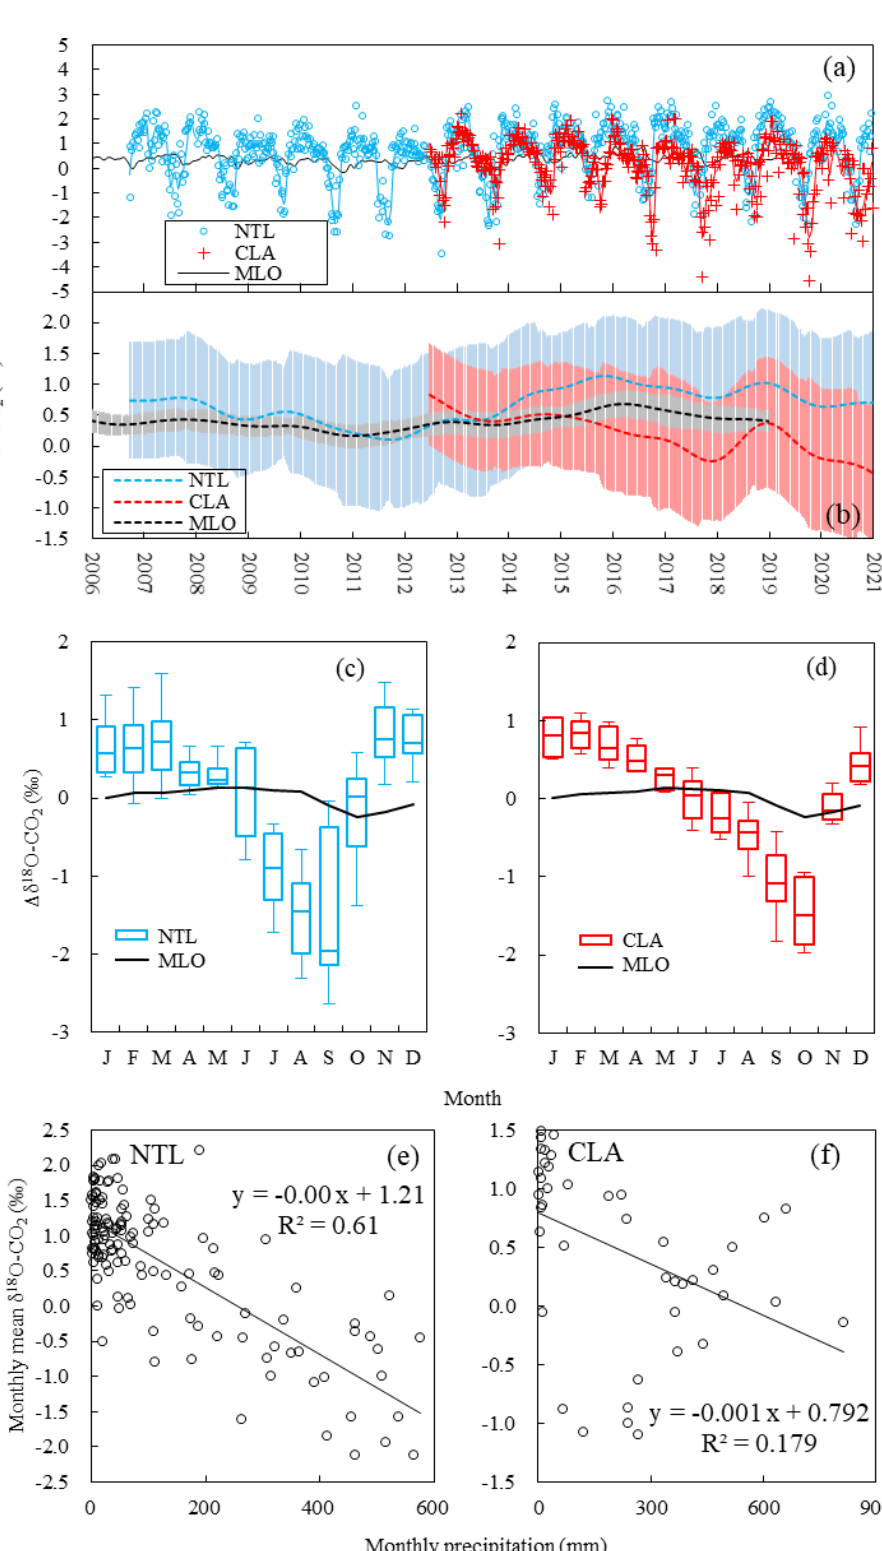
https://doi.org/10.5194/acp-21-16427-2021 Atmos. Chem. Phys., 21, 16427–16452,